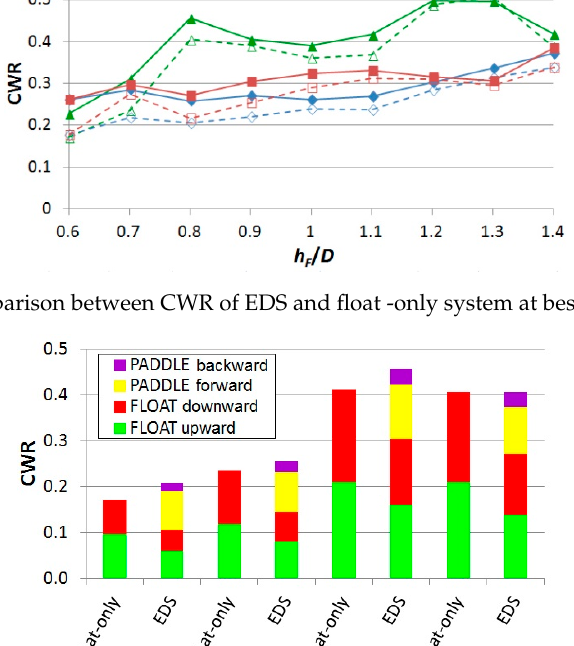
Figure 15. CWR distribution among float and paddle, and motion phases of each body. Wave A.